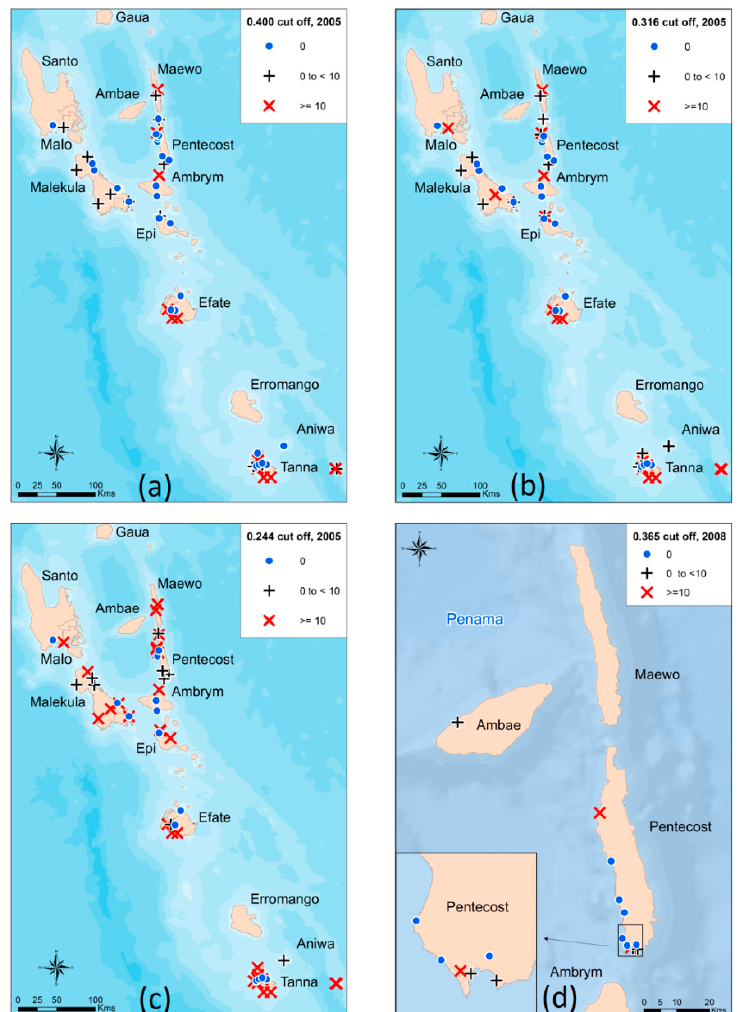
Figure 3. Mapping of antibody prevalence estimates for 2005 and 2008 based on the Bm14 Filariasis CELISA: ( a ) Estimates of antibody prevalence for 2005 when using the original cut-off of ≥ 0.400, ( b ) Estimates of antibody prevalence for 2005 when using the absolute cut-off of ≥ 0.316, ( c ) Estimates of antibody prevalence for 2005 when using the 80% lower threshold cut-off of ≥ 0.244, ( d ) Estimates of antibody prevalence for 2008 when using the 80% lower threshold cut-off of ≥